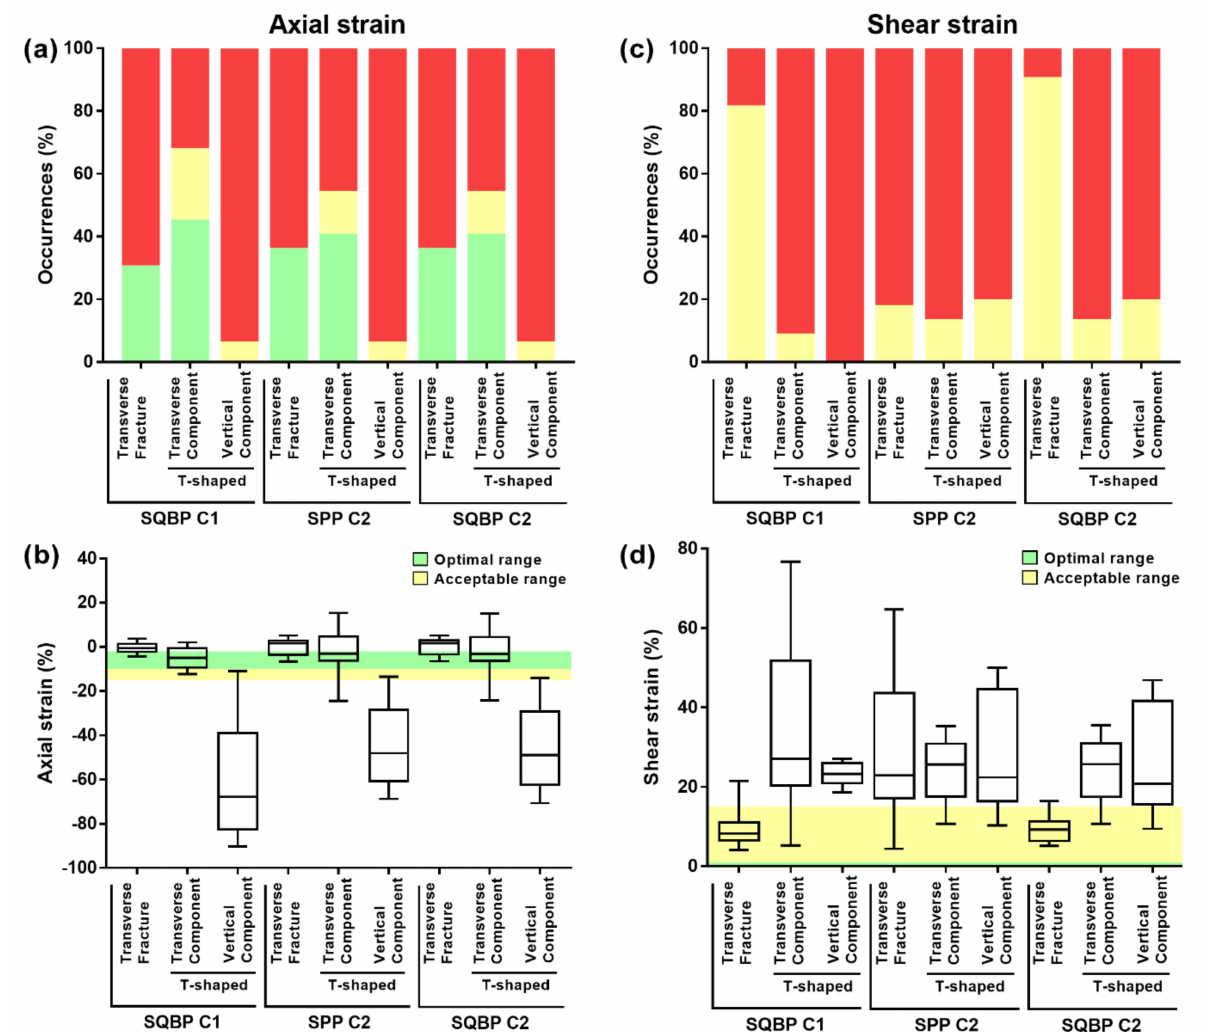
Figure 8. At the panel top, percentage histograms of axial ( a ) and shear ( c ) strains occurrences are shown. In detail, for each points couple the axial and the shear strains were computed according to equations 1 and 2. Obtained axial and shear strains for each points couple were classified according to the ranges listed in Table 5, and percentage occurrences were computed as the ratio between the number of points couples falling within the specific range and the total number of points couples. At the panel bottom, boxplots of axial ( b ) and shear ( d ) strain distributions are shown for each fracture. On each box, the central red mark indicates the distributions median, and the bottom and top edges of the blue box indicate the 25th and 75th percentiles, respectively. The whiskers represent the most extreme data